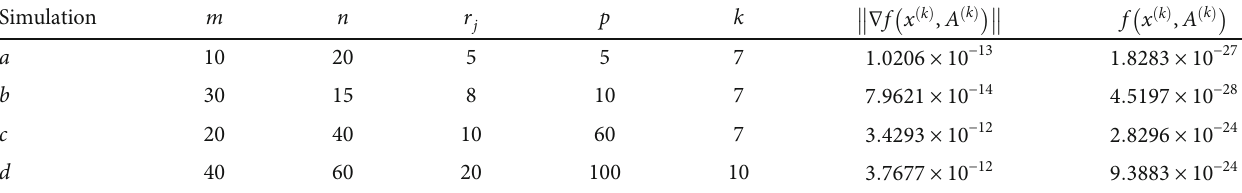
Table 5: Experiment 2: results of problem (9), given by Algorithm 3.